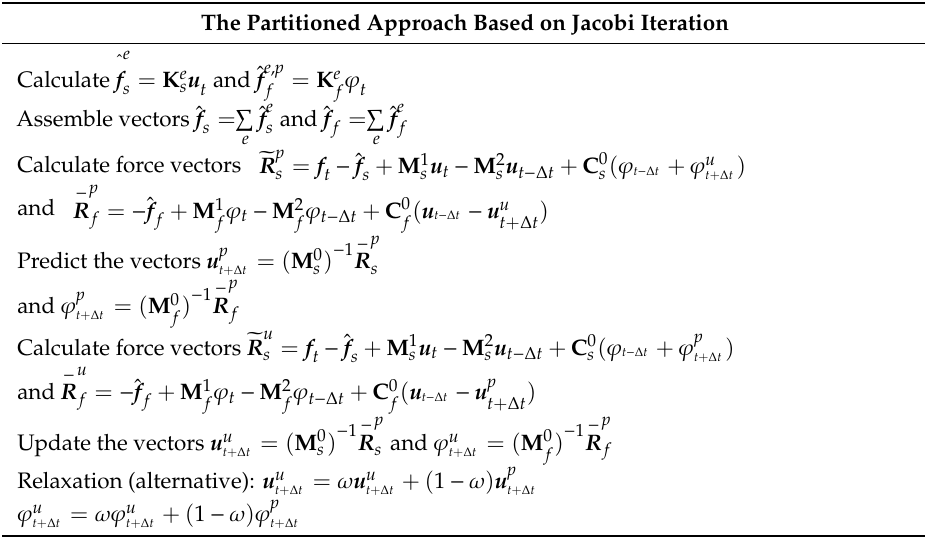
Table 2. The partitioned approach based on Jacobi iteration. The Partitioned Approach Based on Jacobi